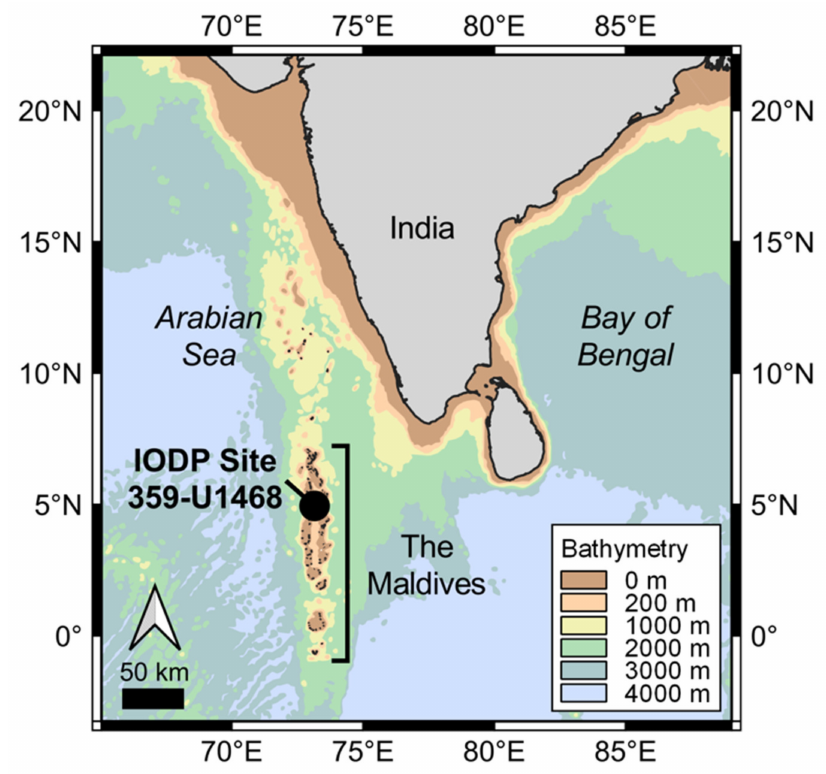
Figure 1. Map of the Maldivian archipelago showing the location of IODP Site 359-U1468. Unit IV (296.4–427.7 mbsf) contains lithified wackestones and packstones with